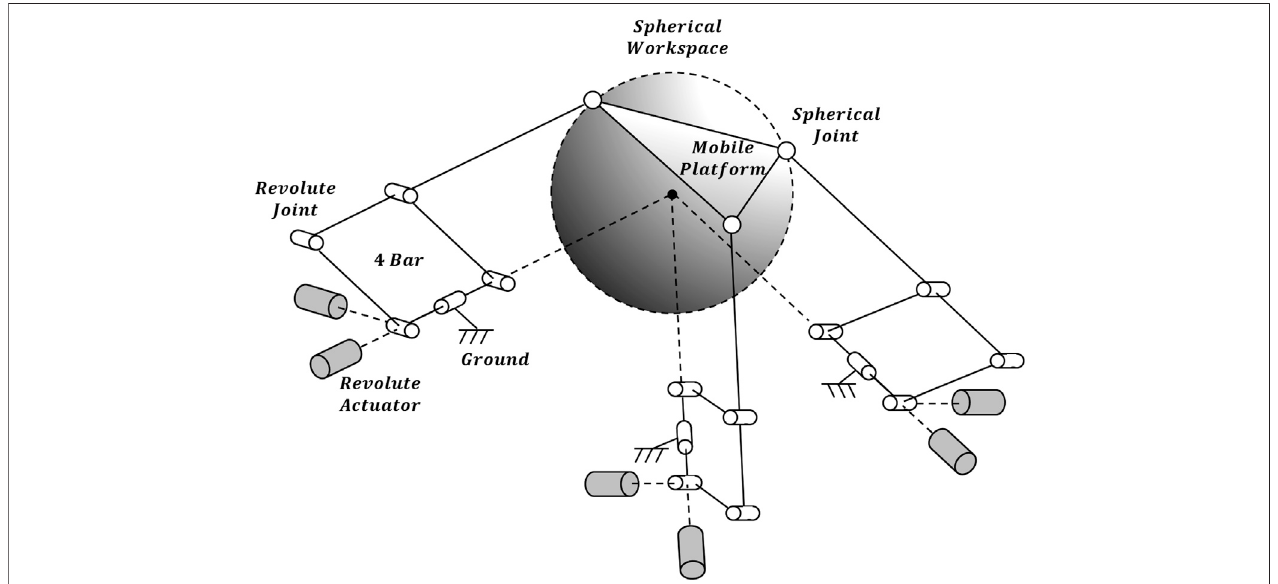
FIGURE 1 | 4-Bar Spherical Parallel Manipulator (4B-SPM) architecture. The 4B-SPM uses three parallelogram 4-bar substructures. Each substructure has two actuated DoF: pitch and roll. The roll DoF axis of each substructure intersects with the others at a singular point which represents the virtual center of a spherical workspace. The top linkage in each 4-bar substructure is extended to reach a mobile platform that moves tangential to the spherical workspace. Each top linkage is coupled to the mobile platform using a spherical joint (Hunt et al., 2017).